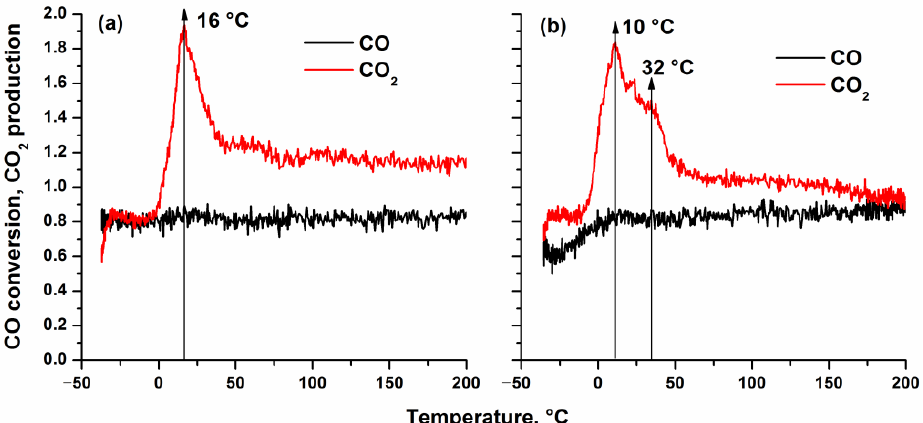
Figure 7. Temperature dependencies of CO conversion and CO 2 production during TPR-CO + O 2 experiments: ( a ) first and ( b ) second heating runs in the reaction mixture. The reaction mixture contains 50 ppm CO, 5 vol.% O 2 , 0.5 vol.% Ne, and He balance. The reaction mixture rate was 100 cm 3 /min. SV = 60 L/g·h.